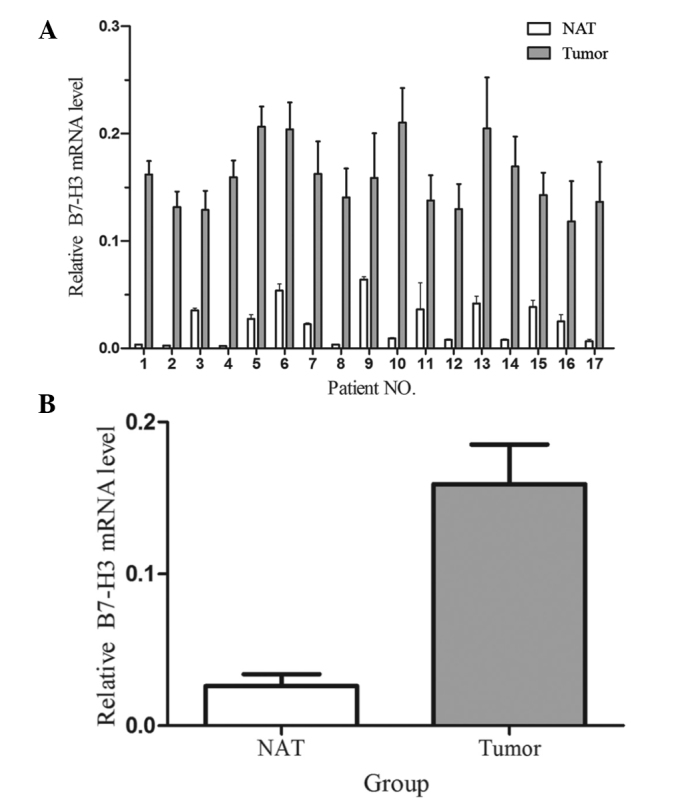
(A) Relative B7-H3 mRNA expression levels of 17 individual paired TCC and NAT samples. The band intensity signal in pixels for B7-H3 was divided by the respective intensity signal of GADPH. The relative B7-H3 mRNA levels were significantly higher in TCC samples compared with the paired NAT samples (P<0.05). (B) The mean relative B7-H3 mRNA level of the TCC samples compared with the NAT samples (P<0.05). TCC, transitional cell carcinomas; NAT, normal adjacent tissue.